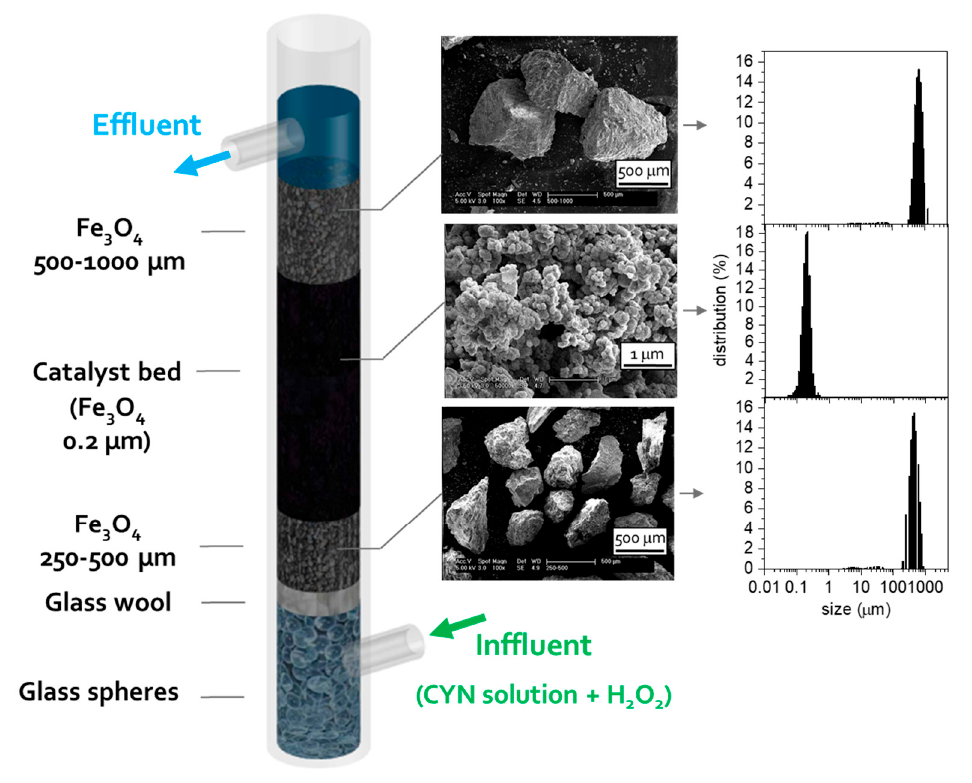
Figure 8. Scheme of the fixed-bed reactor used in the CWPO experiments, including SEM images and the particle size distribution of the Fe 3 O 4 particles.